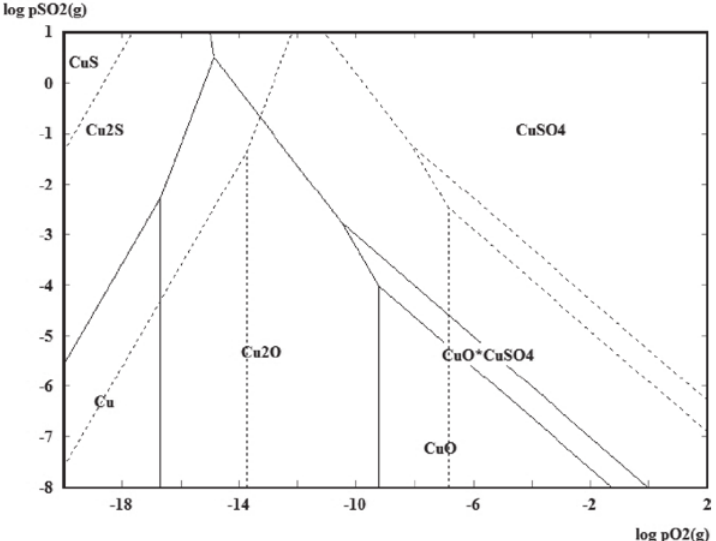
Fig. 5: The stable phases of copper at 450 and 550 °C (···) with oxygen and sulfur dioxide pressures as variables, calculated using the standard database of HSC Chemistry (vers. 6.07)